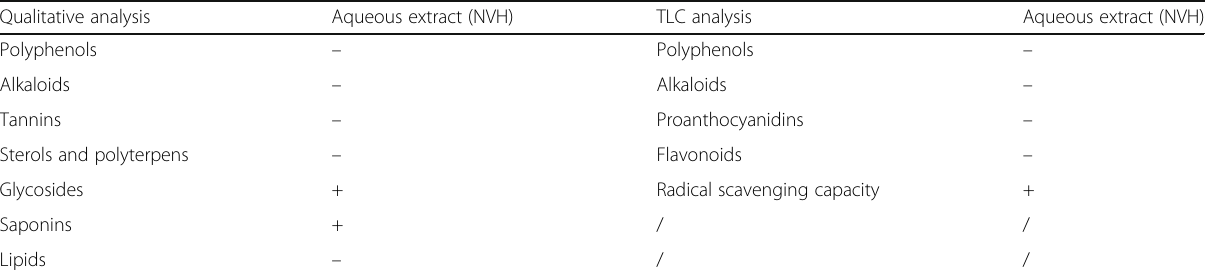
Table 1 NVH qualitative phytochemical